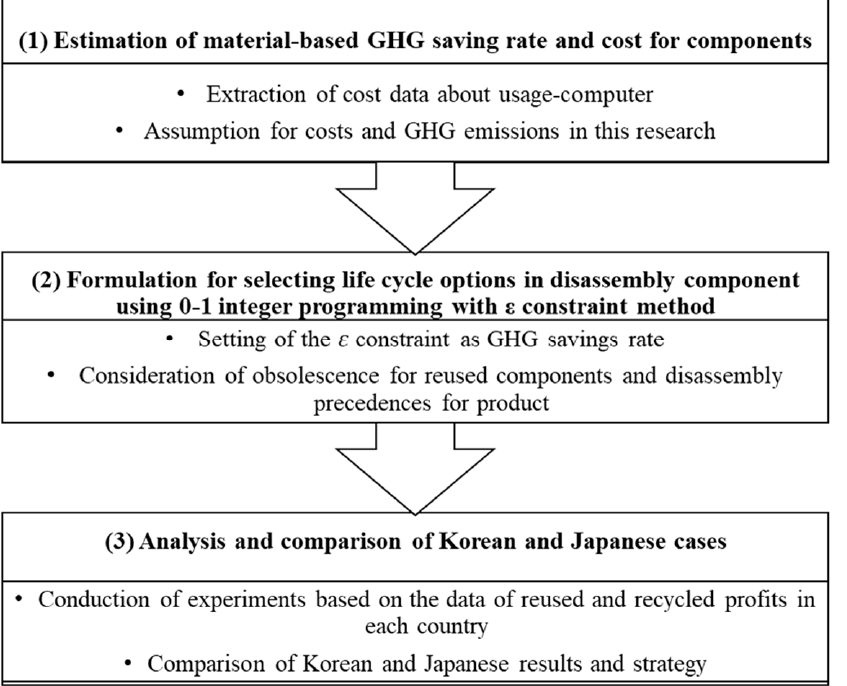
Figure 1. Analysis procedure of reuse and recycling option selection for components.